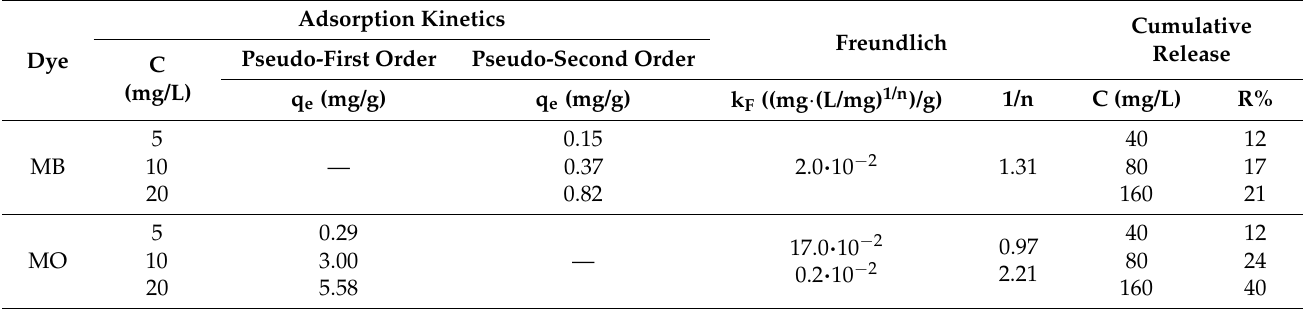
Table 2. Summary of the calculated parameters for the adsorption kinetics, adsorption isotherms, and cumulative release.